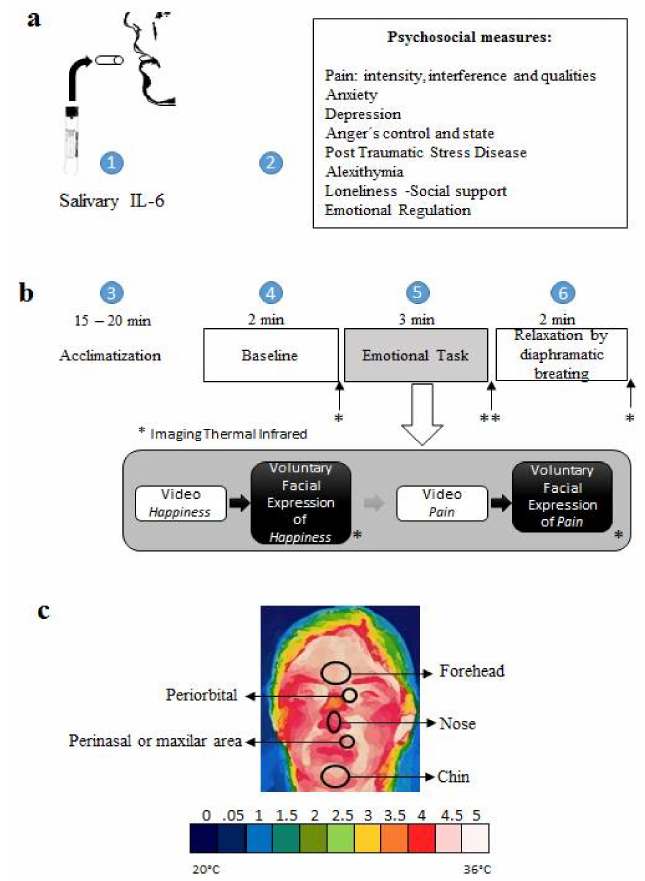
Figure 1. Experimental approaches: ( a ) Salivary IL-6 and Psychological assessment; ( b ) Schematics illustrating the experimental design used in this study with iTF: (1) Baseline (neutral picture). (2) Emotional Task was paradigm Muscle by Muscle to Happy facial expression and Pain facial expression. (3) Relaxation by diaphragmatic breathing; ( c ) Temperature level score and each facial